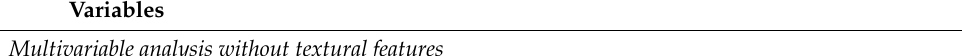
Table 3. Multivariable logistic regression analysis for the relationship between clinical,